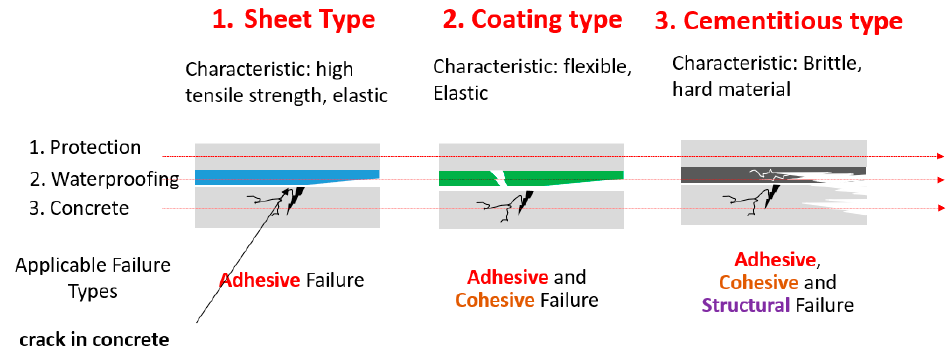
Figure 1. Tensile strain concentration concept (hypothetical) for different types of waterproofing materials